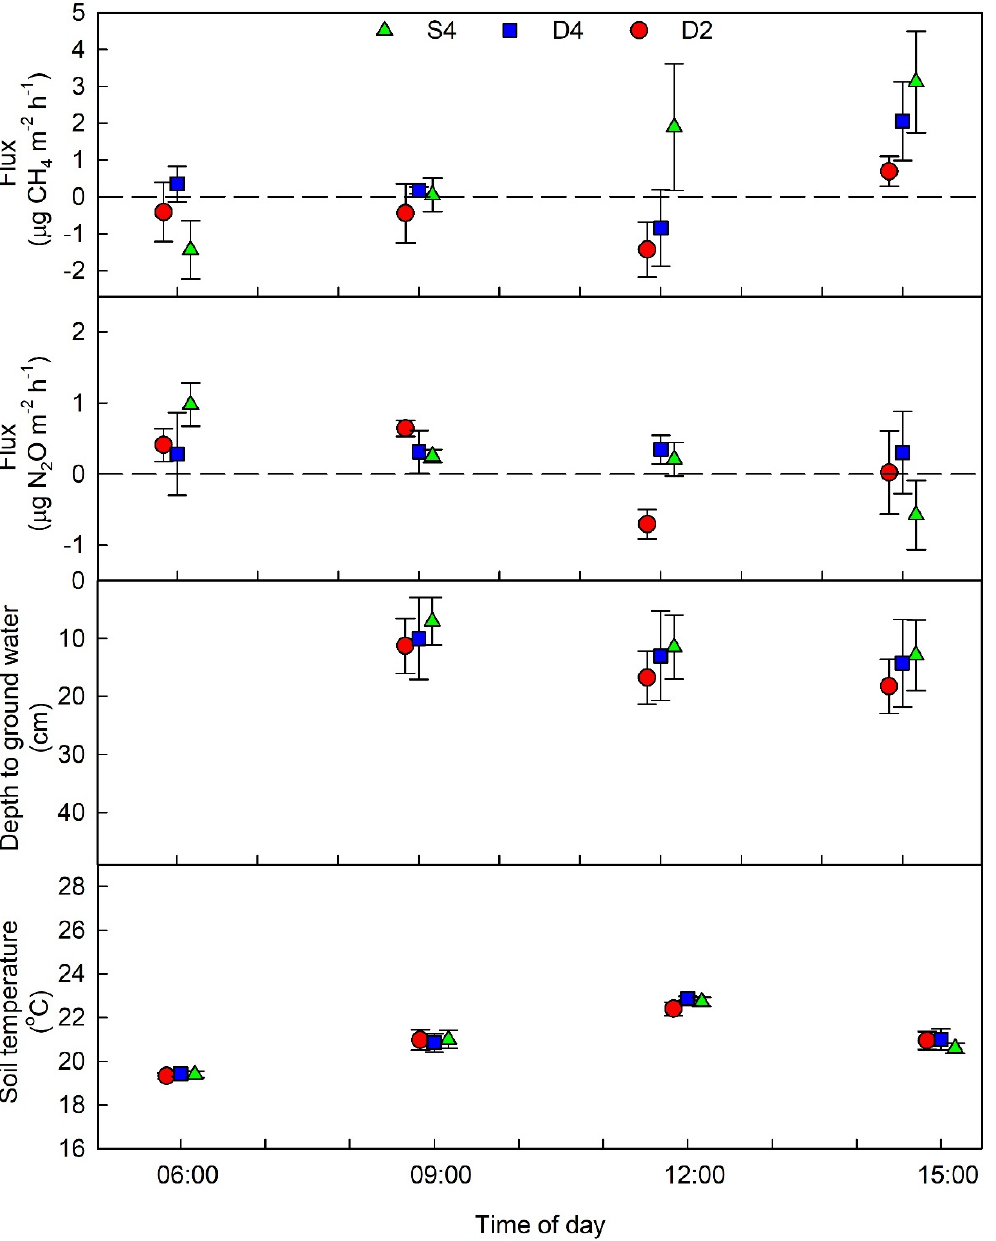
Figure 3. Diurnal pattern in methane (CH 4 ) and nitrous oxide (N 2 O) fluxes, groundwater level, and soil temperature in treatments with: shallow drainage to 0.6 m with weir open four times per week (S4) and deep drainage to 1.2 m with weir open four times per week (D4) or two times per week (D2). Error bars denote one standard error (n ≤ 4). The flux values represent fluxes from the soil-surface including vegetation, with negative values indicating uptake of CH 4 or N 2 O.